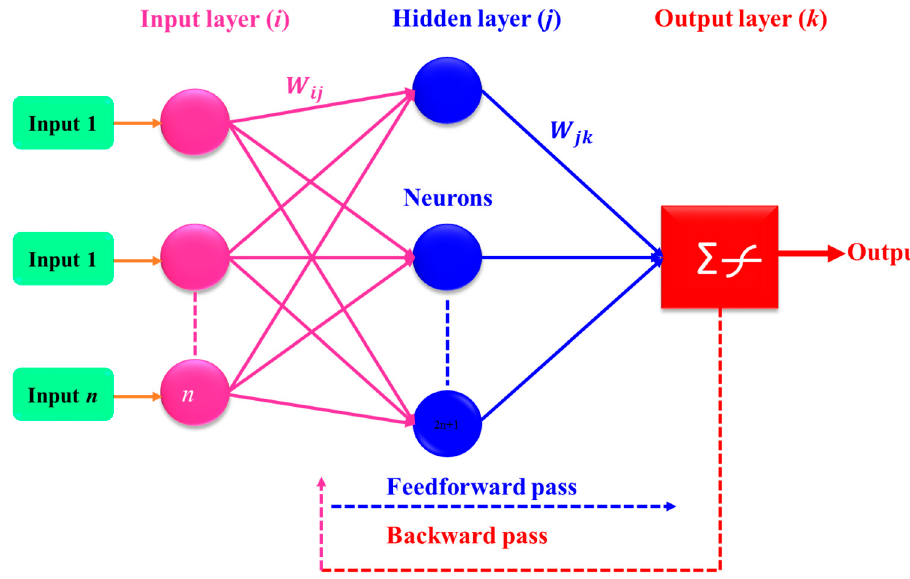
Figure 2. Structure of the artificial neural network (ANN) model.